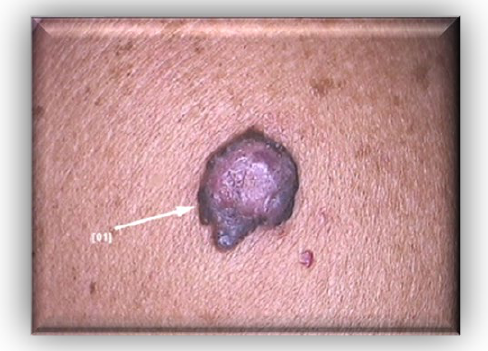
Figure 1. Clinical aspect: asymmetric, dark brown-black nodular tumor, located on the right posterior hemi-thorax.